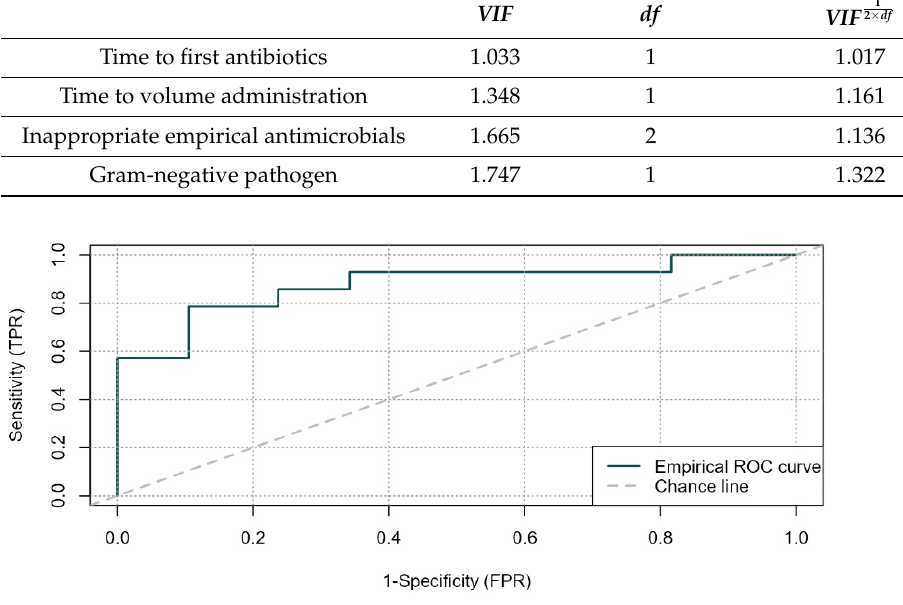
Figure 2. Empirical ROC curve (—) vs. Chance line (---) in multivariate analysis for sepsis-related mortality.